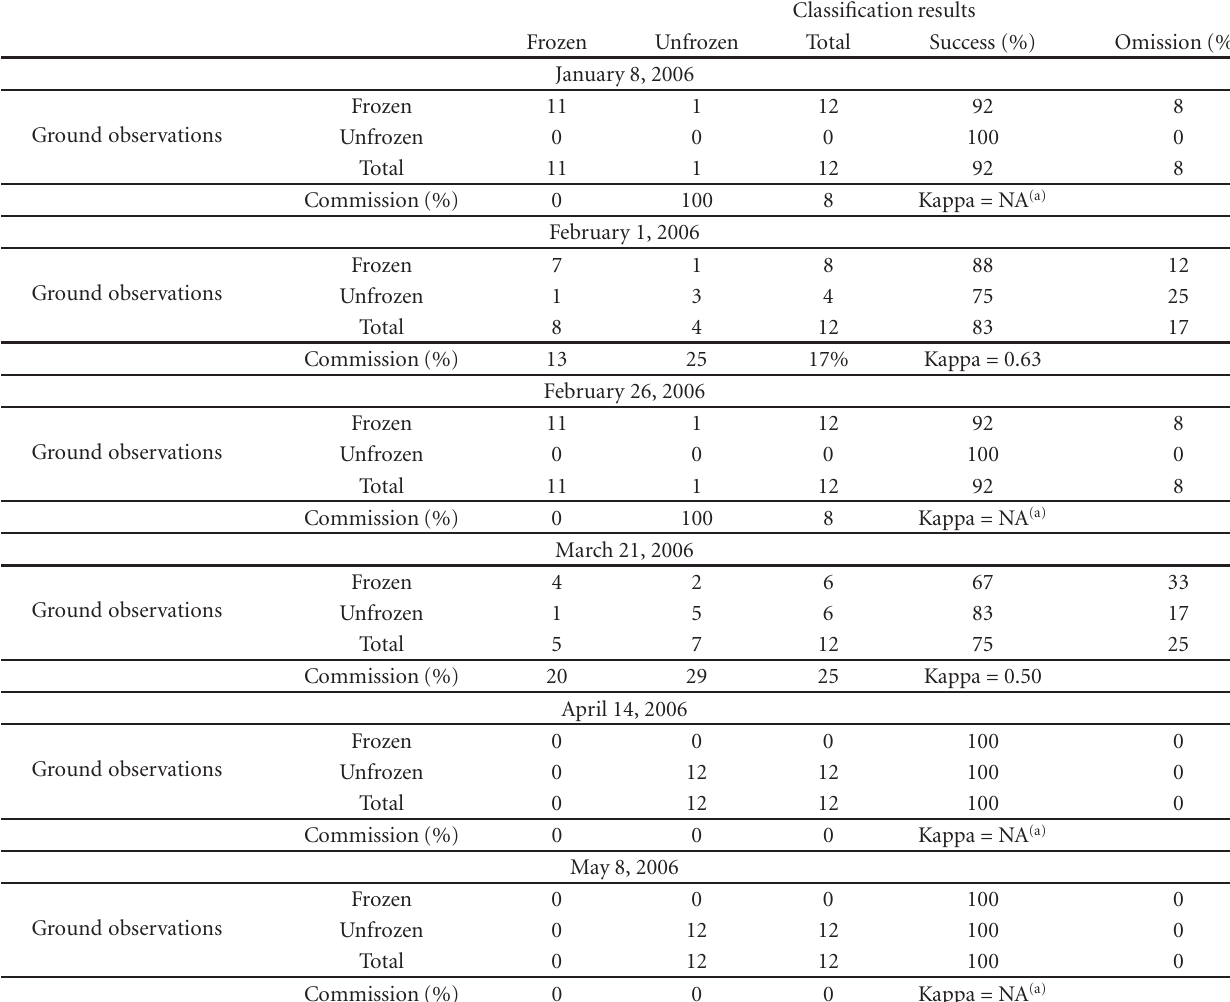
Table 6: Classification results of six selected RADARSAT-1 SAR images compared with soil temperature at the 12 training/validation study fields, by acquisition